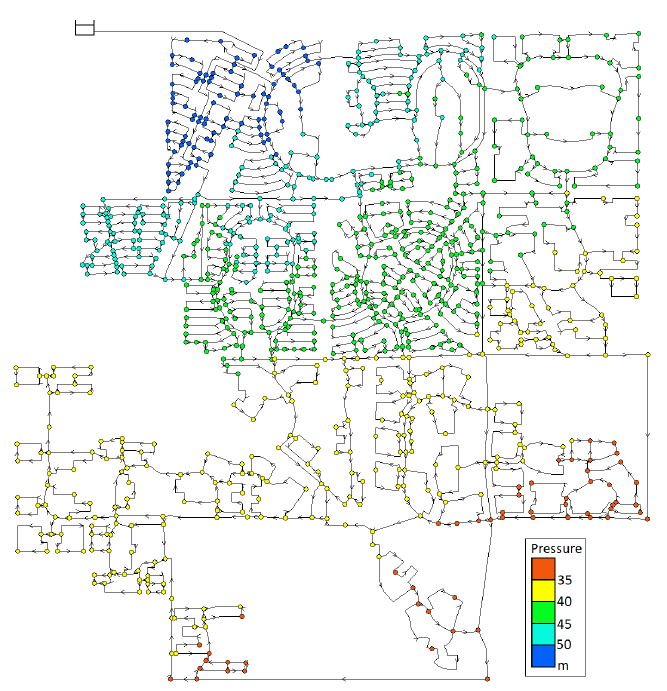
Figure 2. WDN hydraulic simulation result. Pressure regime with P c =